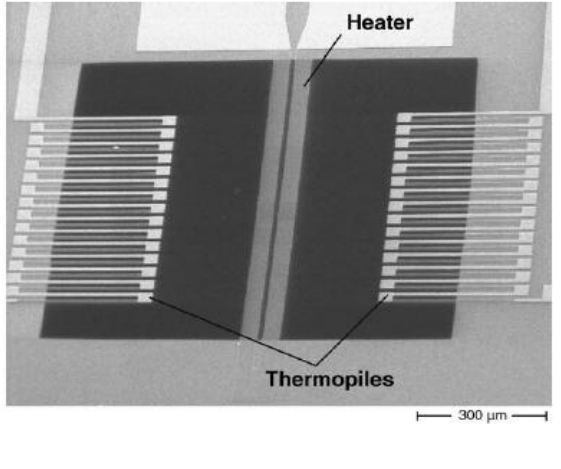
Figure 9. SEM image of thermopiles placed around a heater in a calorimetric configuration for thermoelectric flow sensing [81].